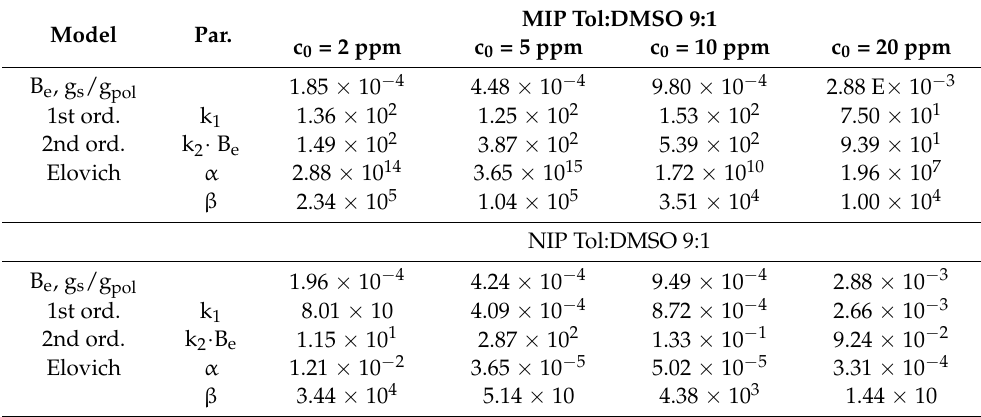
Table 7. The parameters of the kinetic adsorption